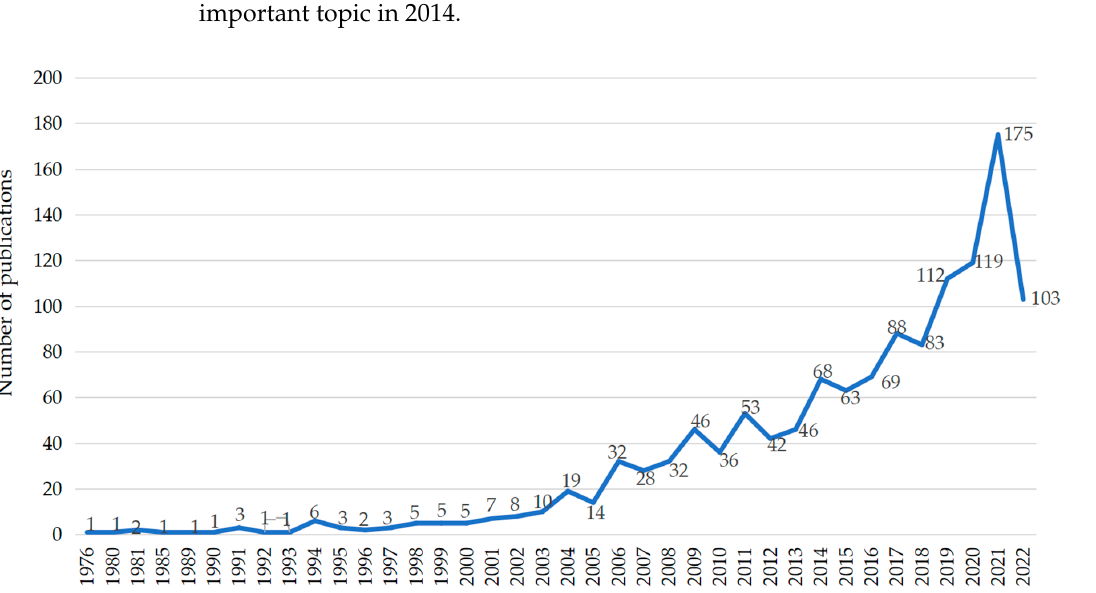
Figure 1. The annual number of RSH-related studies published from 1976 to 2022.